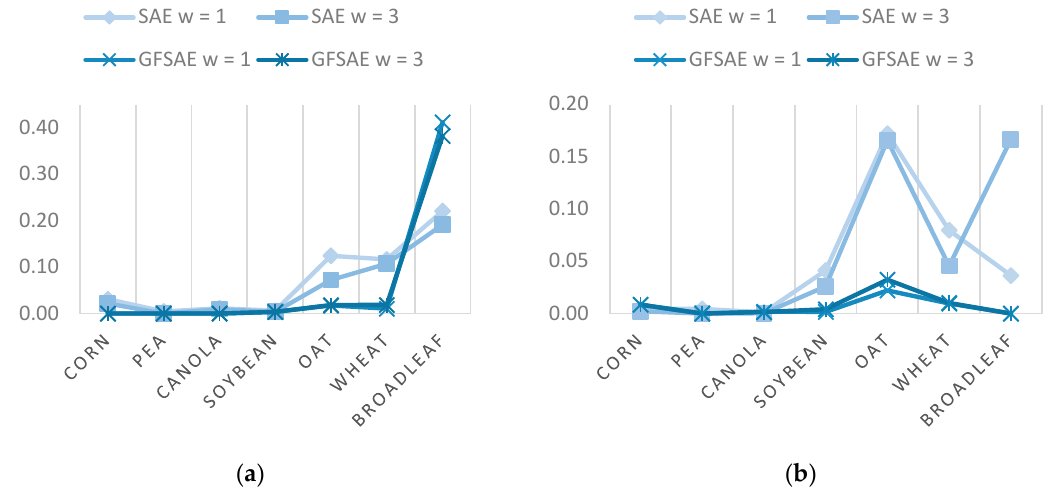
Figure 9. Omission ( a ) and Commission ( b ) errors of different crop types for the Winnipeg dataset. The ground reference map and final classification maps obtained from SAE and GFSAE for all w settings and traditional SVM and RF classifiers are displayed in Figure 10 for the Winnipeg dataset. As we can see, in the case of SAE increasing spatial window size did not have a considerable change in the result maps. However, the classification maps obtained from GFSAE significantly improve the original SAE method. They show more accurate field maps with less confusion with other classes compared to SAE results. Specifically, GFSAE with w = 1 and 3 settings perform best. Comparing SAE- and GFSAE-obtained crop maps with ones of the traditional SVM and RF methods also proves the superiority of the proposed method. Specifically, more accurate and homogenous crop maps are obtained with GFSAE. This again proves the superior performance of the proposed GFSAE method in crop mapping compared to the original SAE and traditional methods.